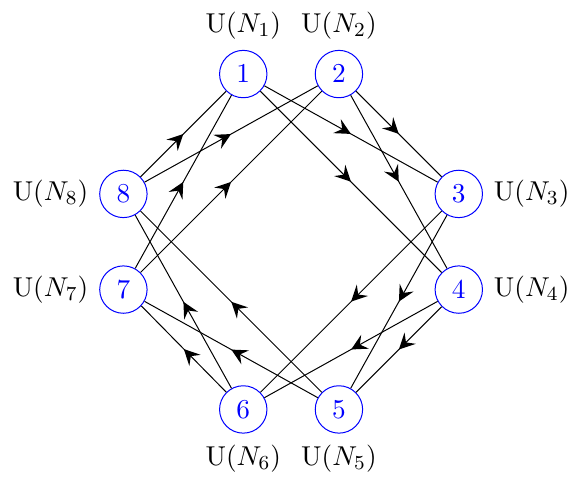
Figure 3 . Quiver diagram for a D3-brane at a dP 5